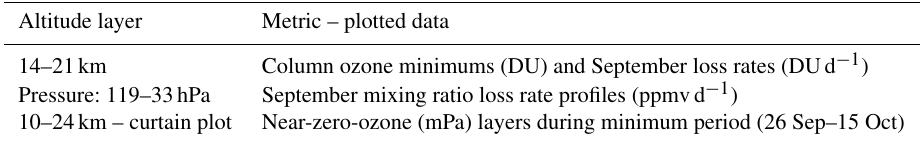
Table 2. Altitude layers and metrics updated for the 1986–2021 ozonesonde record at the South Pole. Altitude layer